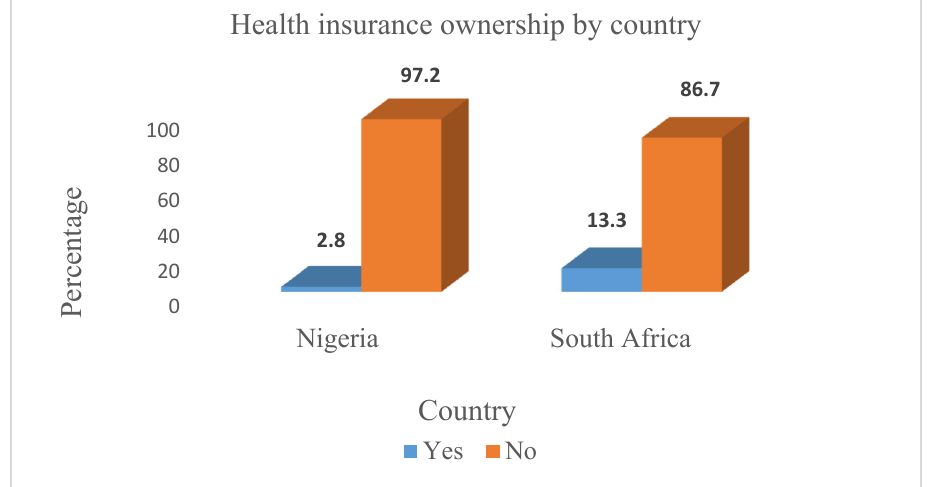
Figure 1. Distribution of health insurance ownership in Nigeria and South Africa.